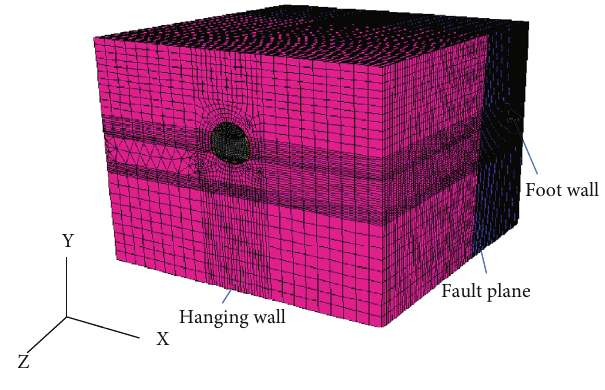
Figure 2: 3D numerical calculation